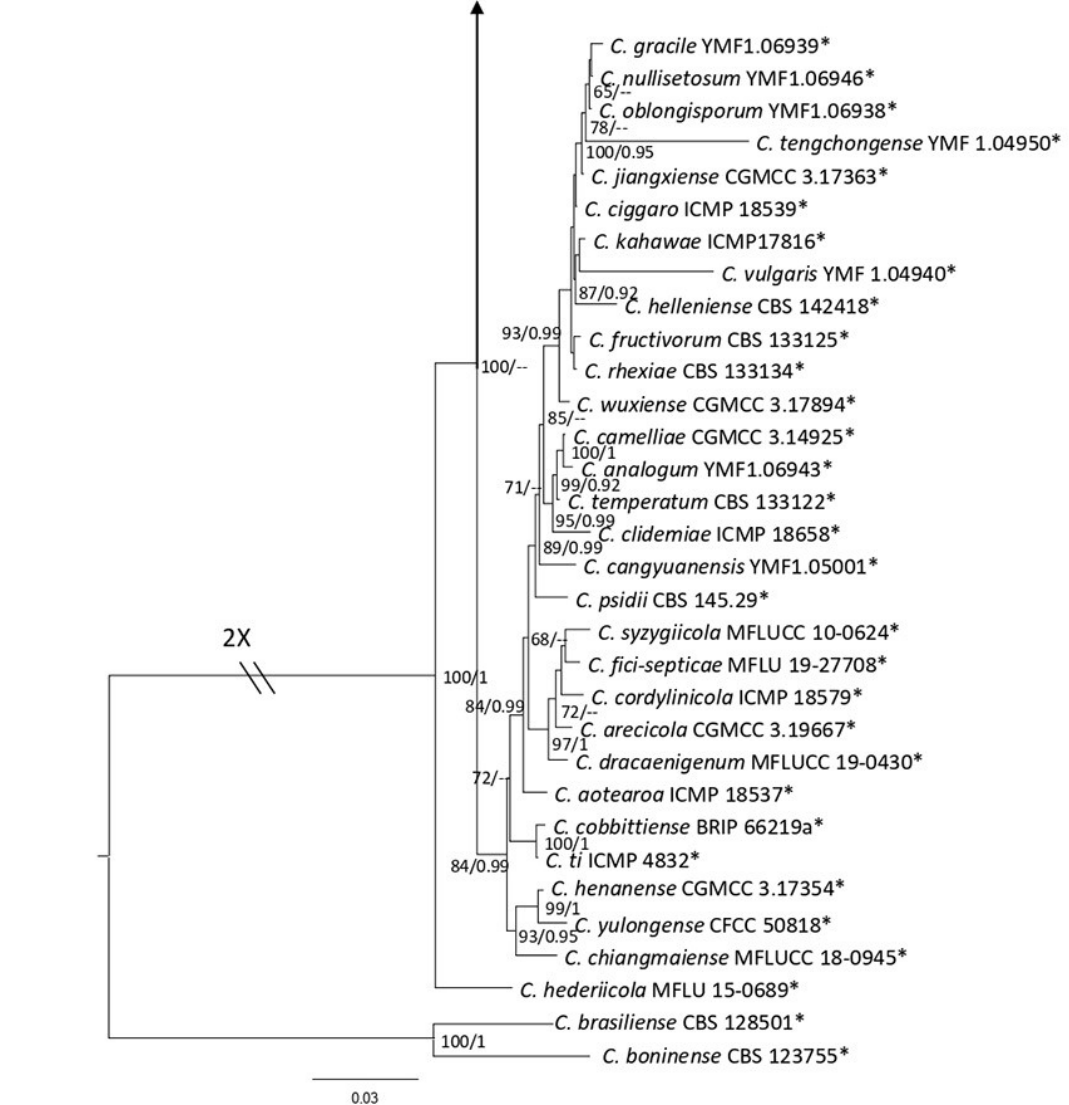
Figure 21. The Colletotrichum gloesporioides complex. The Bayesian phylogenetic tree obtained from the combined act , chs-1 , gapdh , ITS, and tub2 sequence data. The ultrafast maximum likelihood bootstrap support (%) ≥ 50 and BYPP ≥ 0.90 are shown at the nodes. The ex-type strains are marked with an asterisk. The tree is rooted in C. braseiliense (CBS 128501) and C. boninense (CBS 123755). Colletotrichum fructicola Prihast., L. Cai & K.D. Hyde, 2009. Facesoffungi number: FoF 06767; Figure 22.